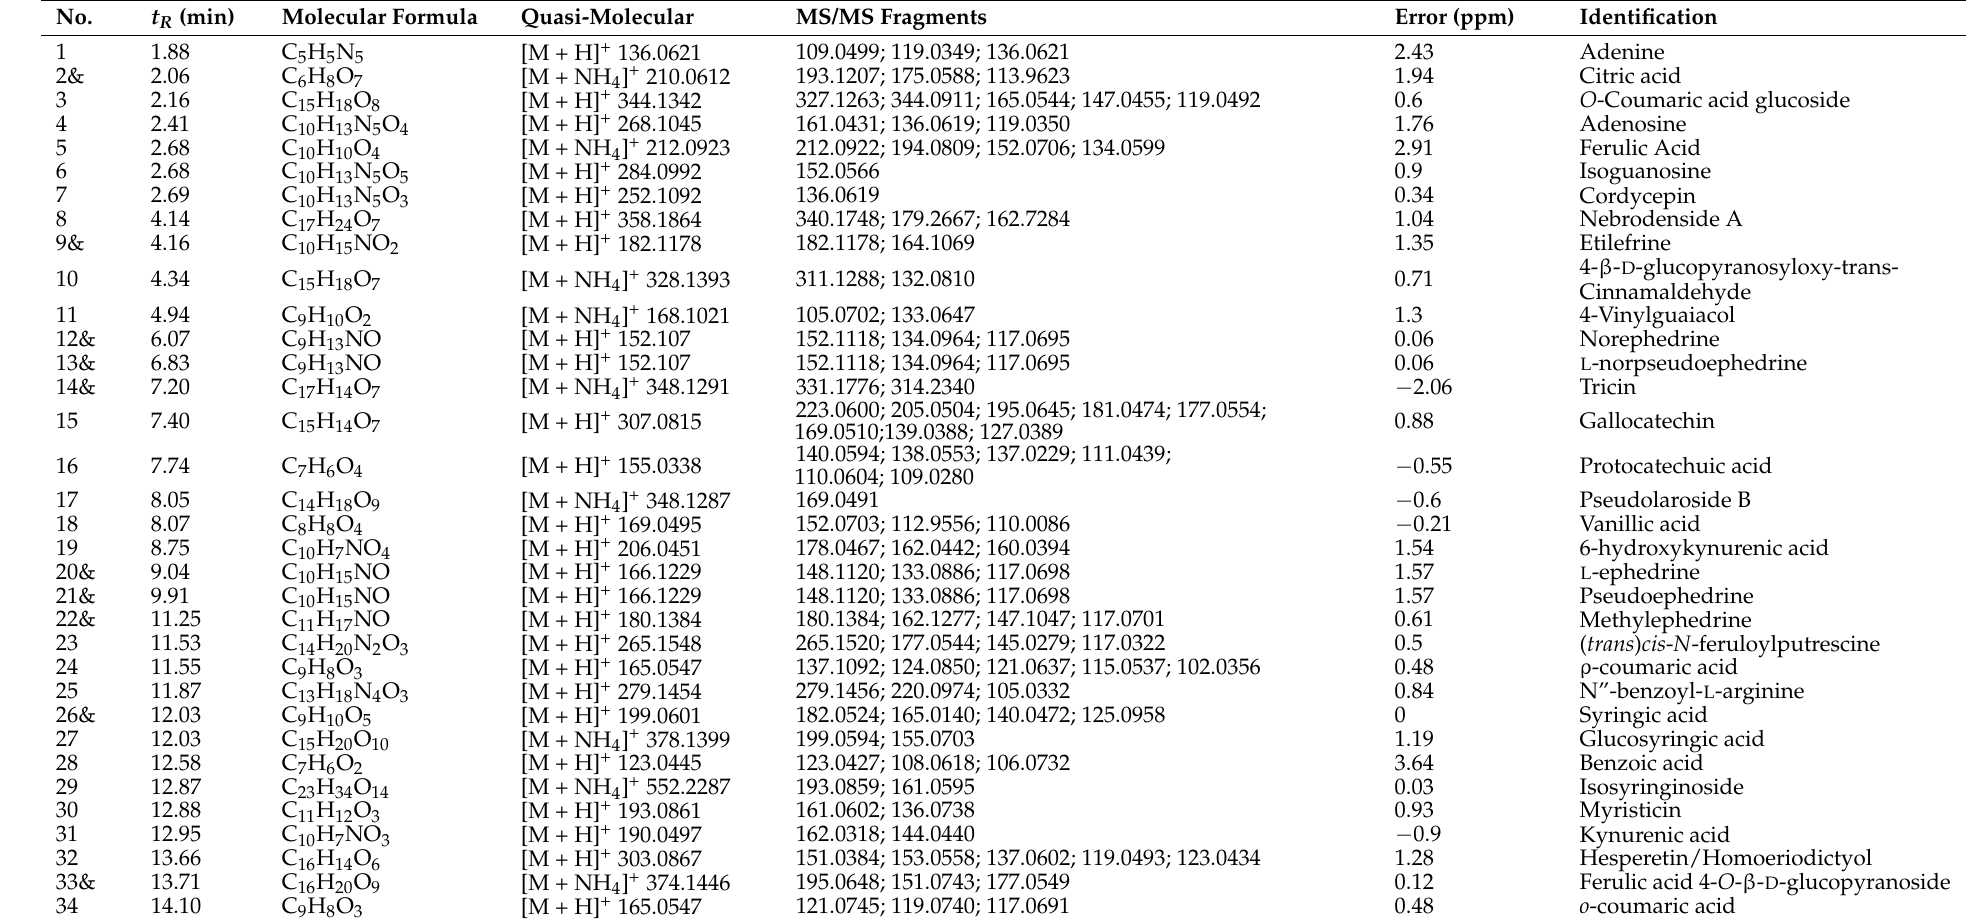
Table 1. Information on 65 compounds in P1 identified by